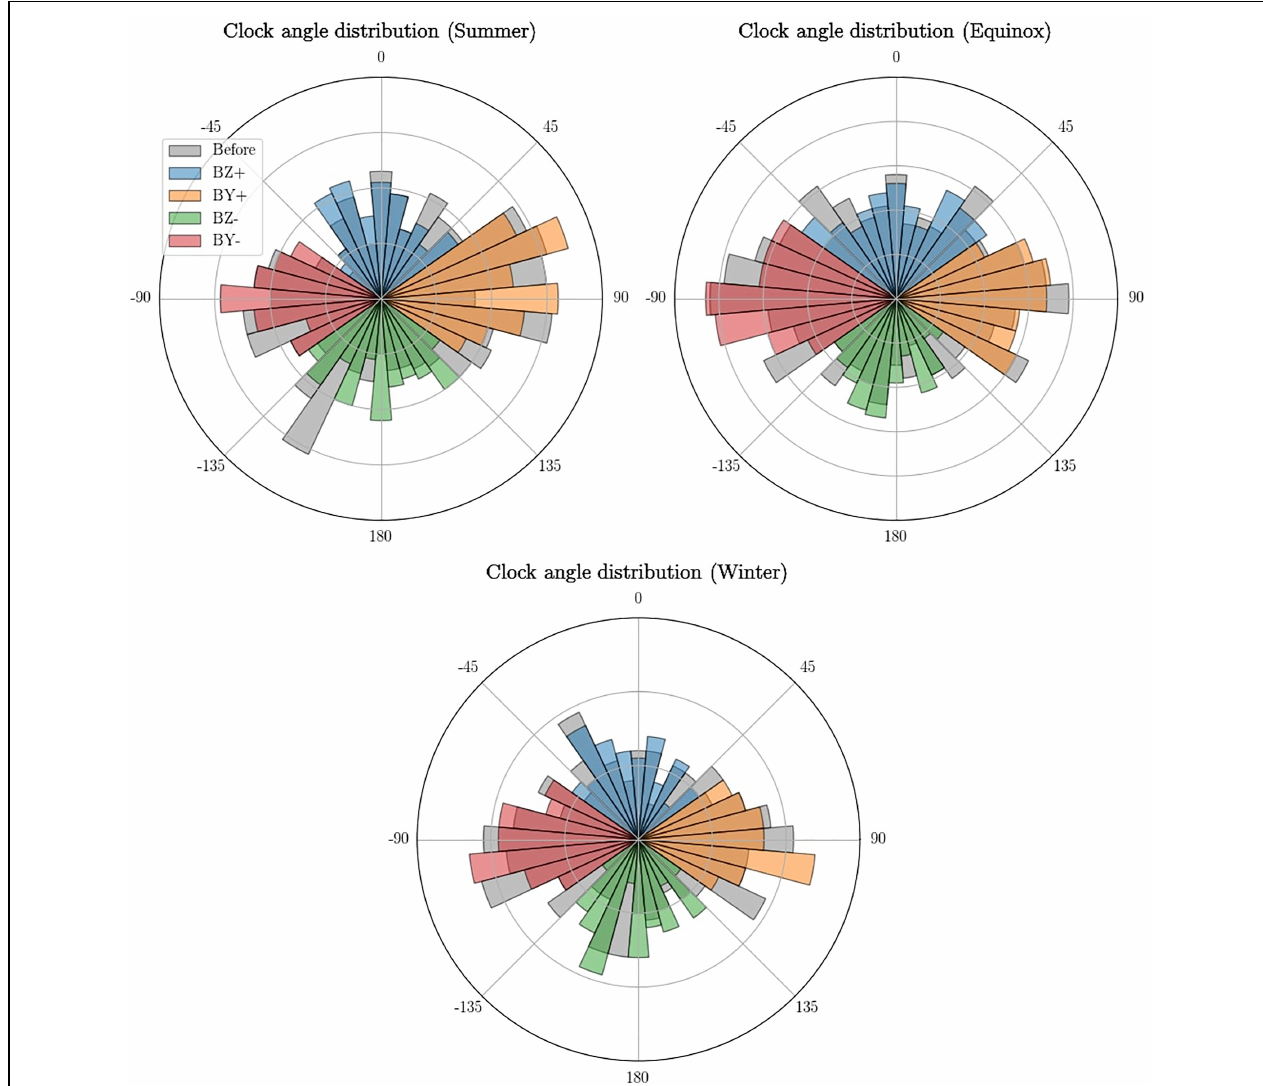
FIGURE 8 | Polar histograms of the IMF clock angle distribution in each of the 12 groups. The grey bars indicate the distribution before the increase in P d while the colored bars indicate the distribution after. Each circle represents 10